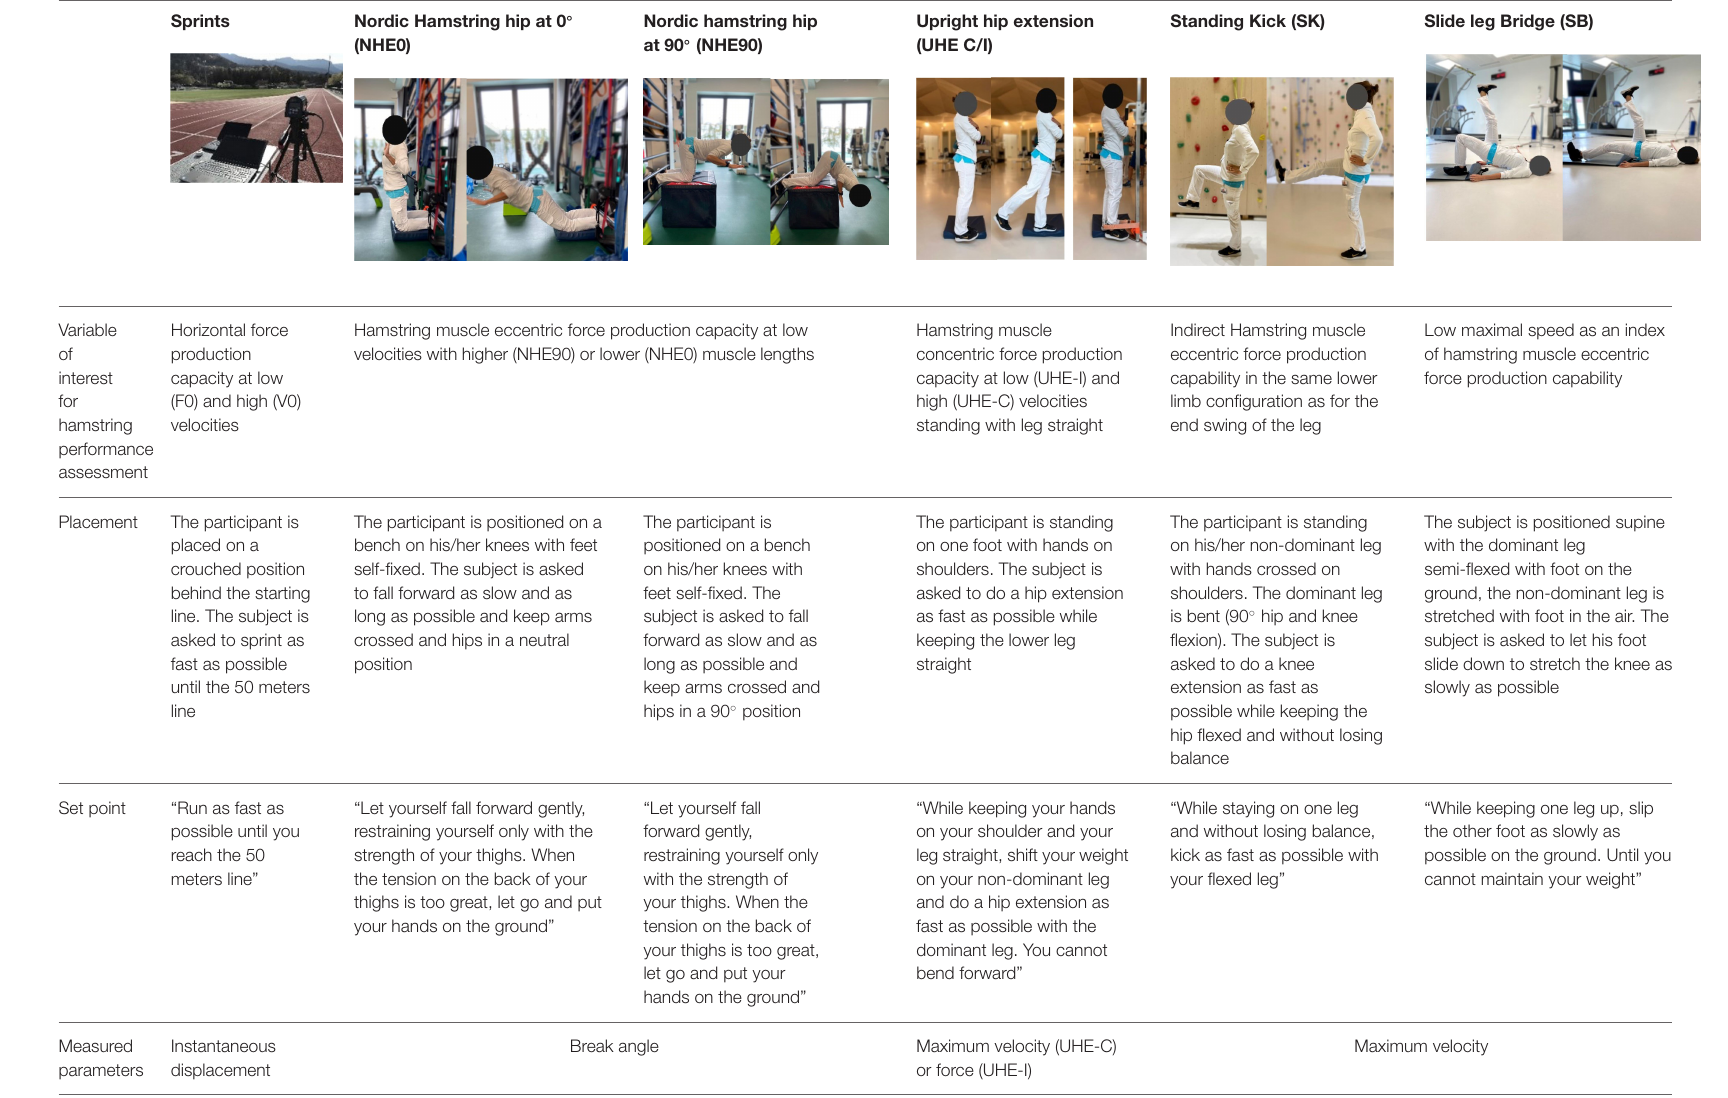
Nordic hamstring hip at 90 ◦ (NHE90)